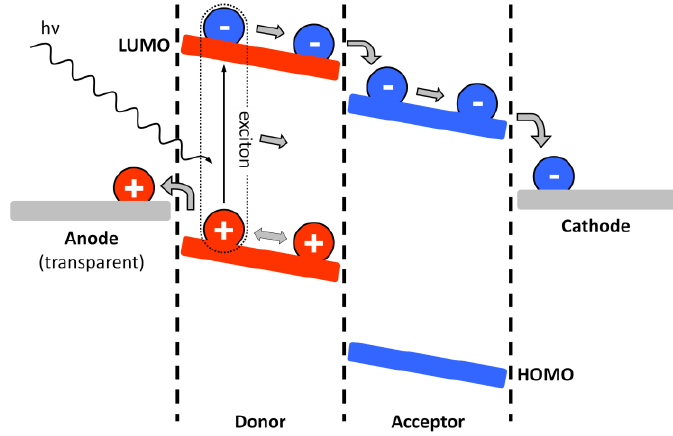
Figure 3. Schematic depiction of energy conversion in an organic photovoltaic cell. Absorption of light leads to the generation of excitons. The offset between the donor and acceptor energy levels (LUMO and HOMO) causes the excitons to separate. Reprinted from Materials Today, Vol. 13, I. Botiz and S.B. Darling, Optoelectronics using block copolymers [25]. Copyright 2010, with permission from